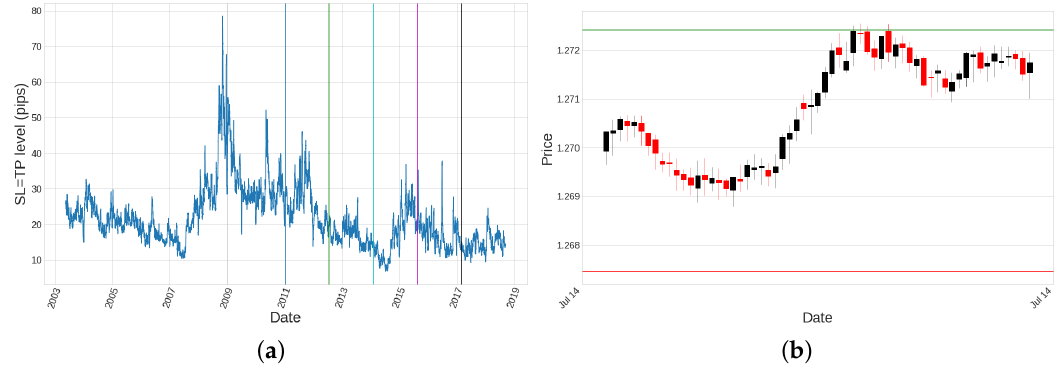
Figure 13. ( a ) Average volatility for the 60-min timeframe experiences different periods during 2003–2018. Vertical lines have been drawn at the beginning of each out of sample period. This is the reason that, even though TP = SL , the average amount of pips for the winning trades are not the same as the average amount of pips for the losing trades. ( b ) Example of a specific trade evolution in 1-min timeframe: it corresponds to candlestick ID 44, first out of sample period, timeframe of 60 min, operation number 1112, opened at the open price on 2010-07-14 at 09:00, and closed at 09:36, just when the high value of the price touched the TP